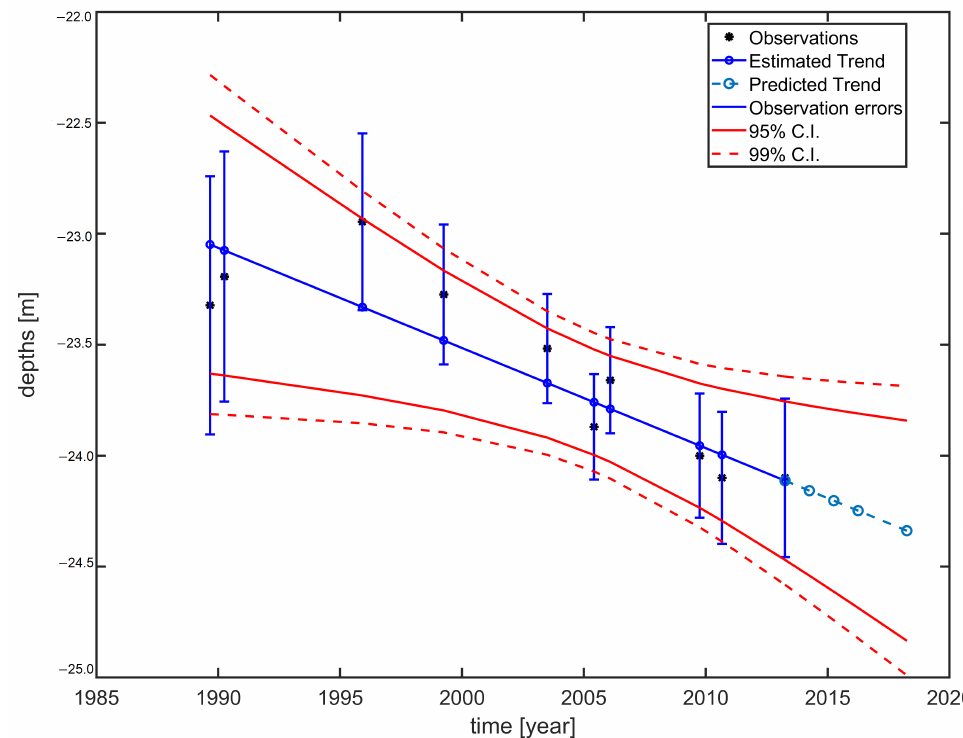
Figure 5. Example showing the principle of the observed depth, d in relation to the estimated trend (BLUE) and predicted trend, including the 95% and 99% confidence interval around the estimated trend and the predicted